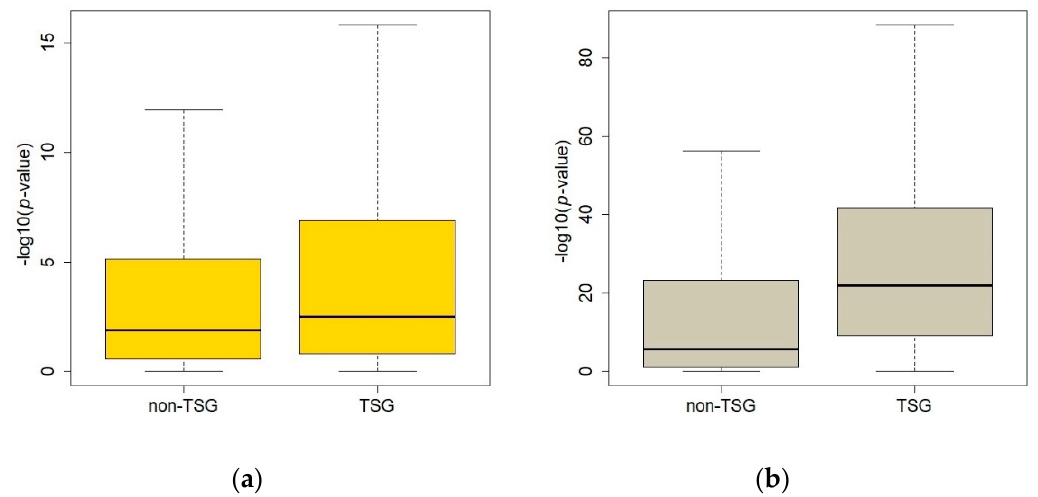
Figure 6. Comparison of p -values of the multi-omics analysis between tumor suppressor genes (TSGs) and non-TSGs. ( a ) Results of regression analysis between copy number alterations (CNAs) and methylation; ( b ) results of CNA-gene expression analysis. The difference is more obvious in the comparison of the results from the copy number and gene expression analysis. TSG: tumor suppressor genes.